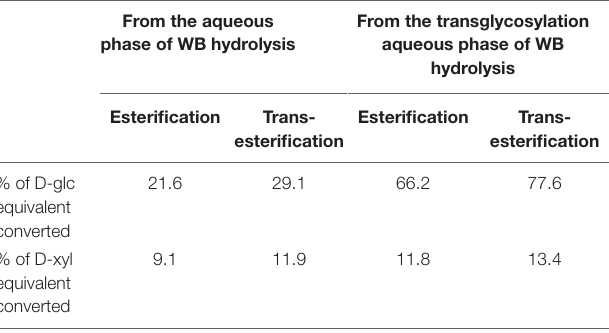
TABLE 3 | % of glucose and xylose from WB converted into laurate esters catalyzed by the lipase N435 from glucose and xylose present in the hydrolysate (hydrolysis reaction) or in the transglycosylation phase (transglycosylation reaction) after 72 h of acylation